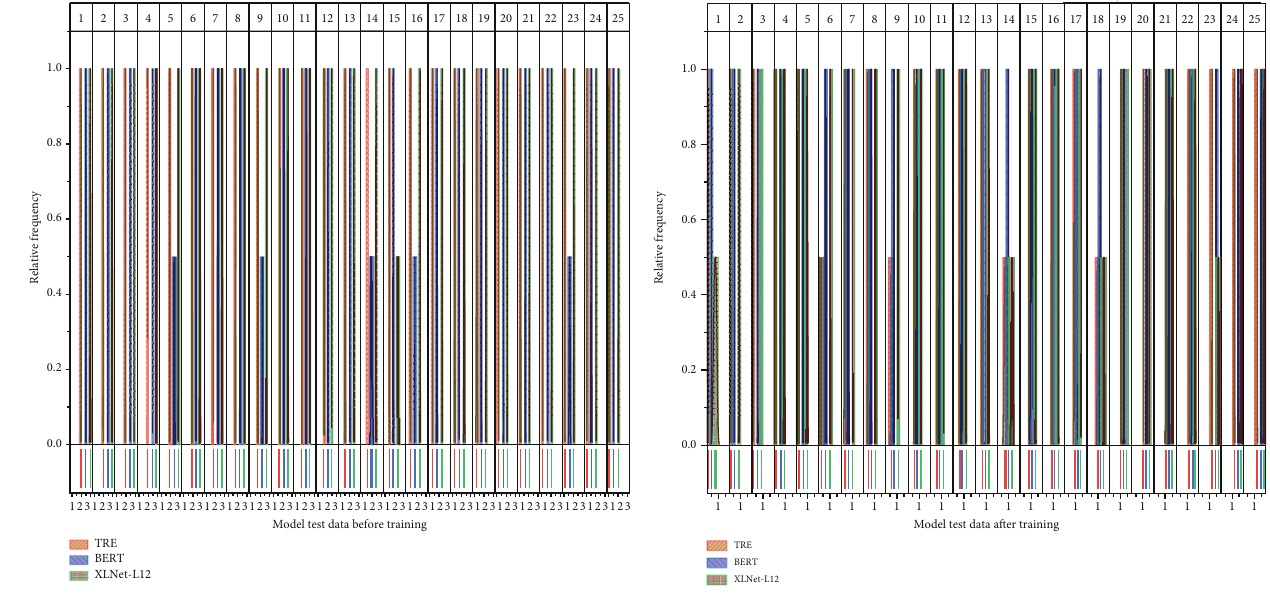
Figure 5: Training results of the three